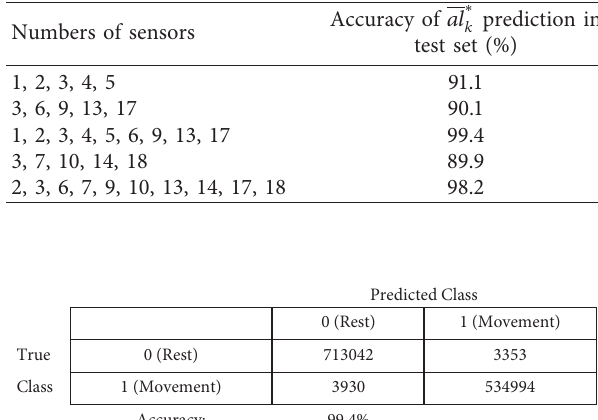
Table 2: Accuracy with different numbers of sensors.